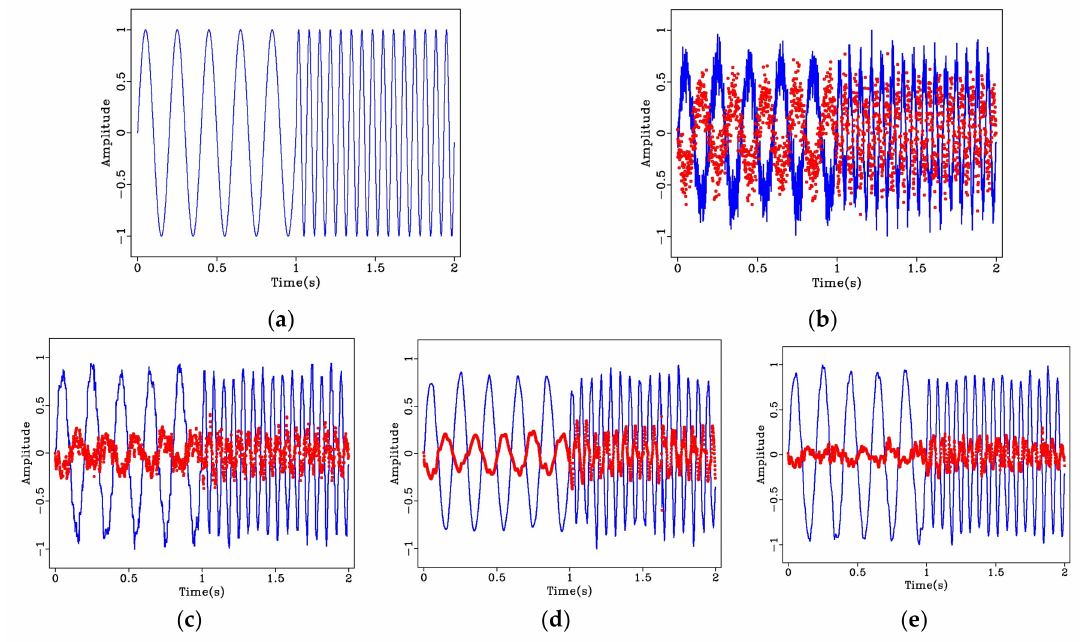
Figure 3. Synthetic dual-frequency chirp signal and denoising e ff ects: ( a ) Original signal; ( b ) original noisy signal; ( c ) signal using median filtering; ( d ) signal using wavelet denoising, and ( e ) signal using bilateral filtering. The dotted red line represents the residual noise.